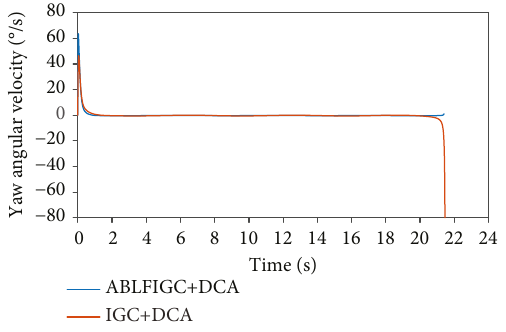
Figure 13: Yaw angular velocity curves of the interceptor missile in Scenario 2: ABLFIGC+DCA refers to a combination of the proposed asymmetric barrier Lyapunov function-based IGC algorithm and the dynamic control allocation algorithm; IGC+DCA refers to a combination of the IGC algorithm subject to the traditional dynamic surface sliding-mode control law and the dynamic control allocation